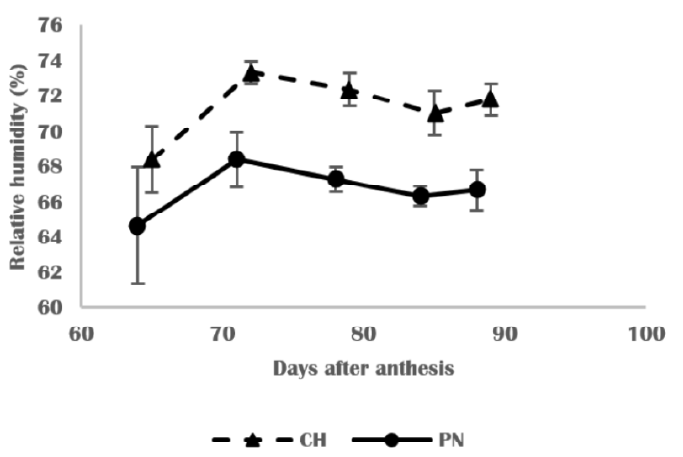
Figure 2. Relative humidity (RH%) in grape skin from Pinot noir ( • ) and Chardonnay ( (cid:78) ) grapes. Means of 3 replications ± SD.